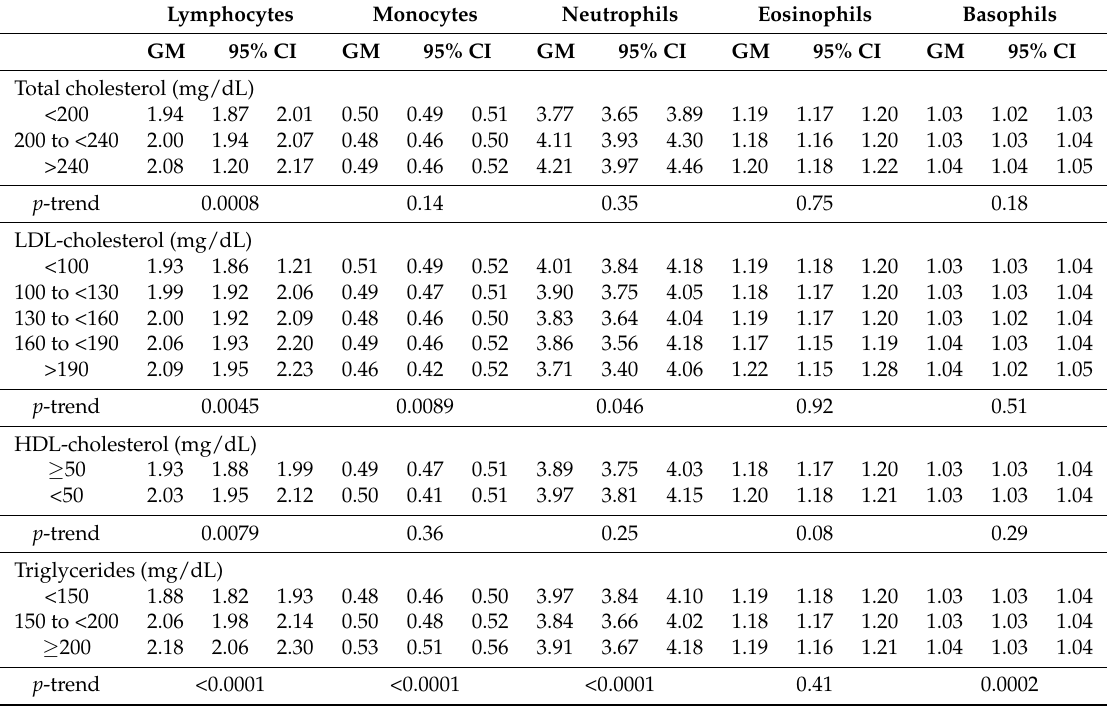
Table 3. Serum lipids are differentially associated with peripheral leukocyte counts in women from NHANES